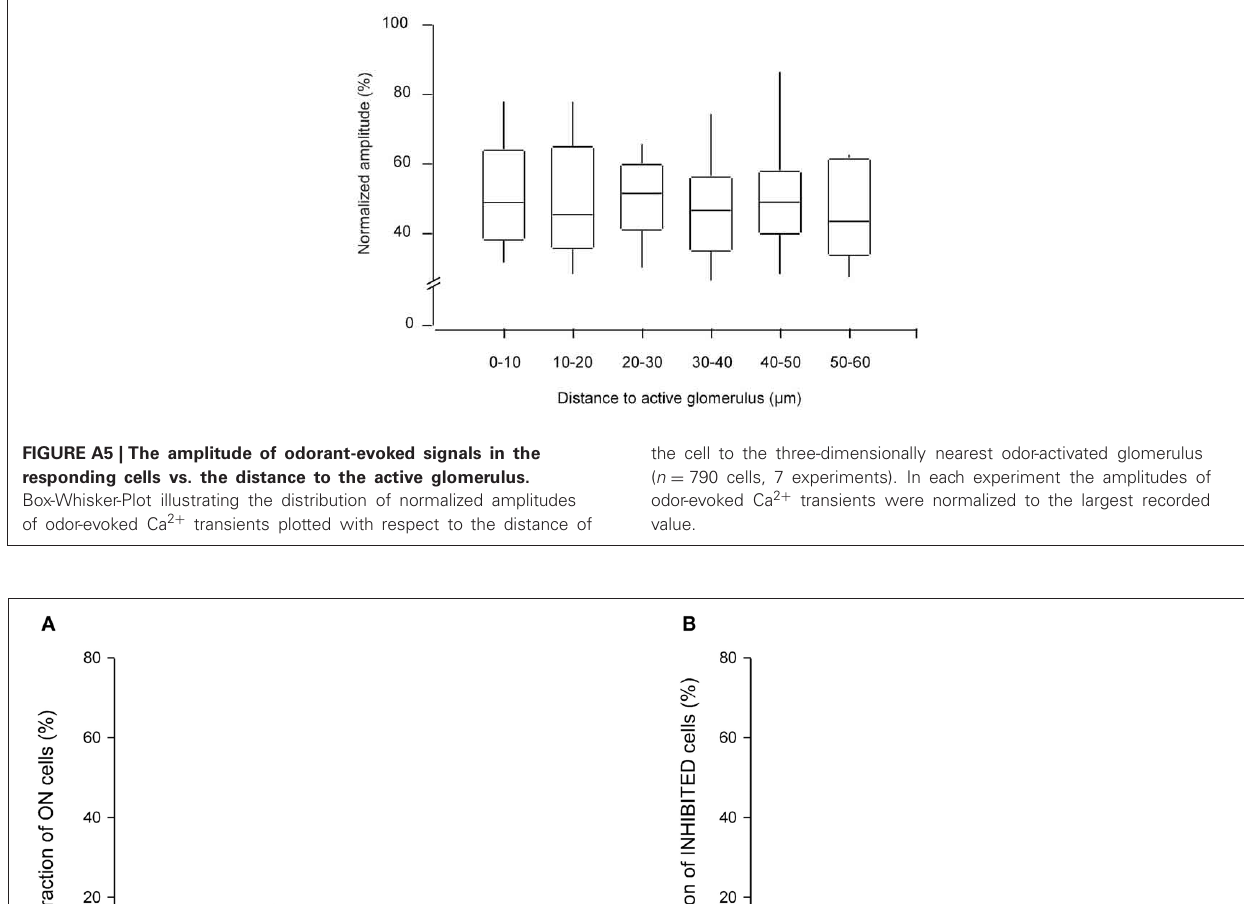
response ( n = 5 experiments, 596 cells). (B) Histogram summarizing the distance of all INHIBITED neurons to the three-dimensionally nearest glomerulus with ON response ( n = 5 experiments, 89